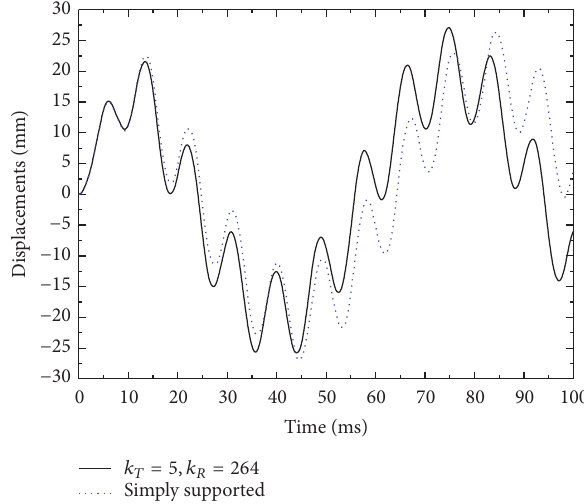
Figure 10: Transverse displacement history at the edge point with different restraints.